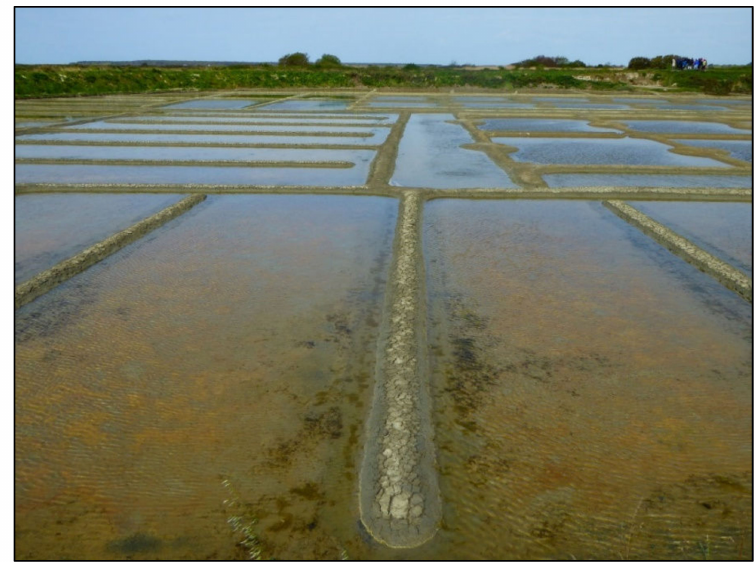
Figure 4. Winter view of the salt pans of one productive unit in the marshes of Gu é rande. These pans will be cleaned before the next salt making season. Own